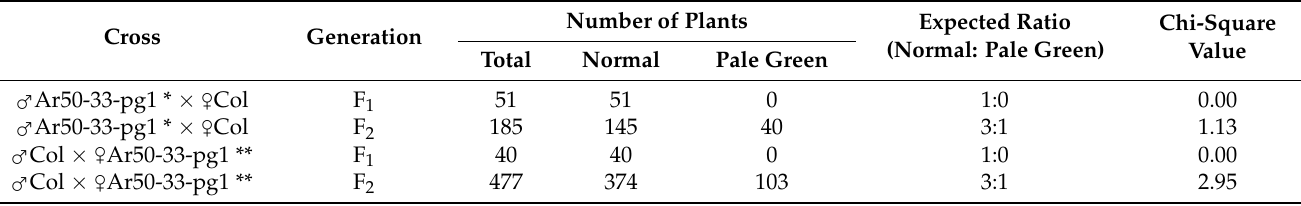
Table 1. Segregation analysis of Ar50-33-pg1. Phenotypes of F 1 and F 2 seedlings after growth on MS media for 14 days. The pale green phenotype at the seedling stage was also observed in the flowering stage.